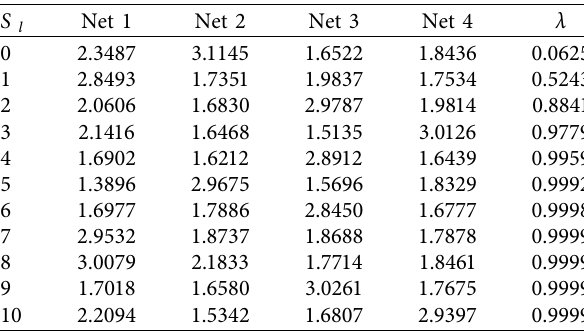
Table 3: Effect of sensitivity on network